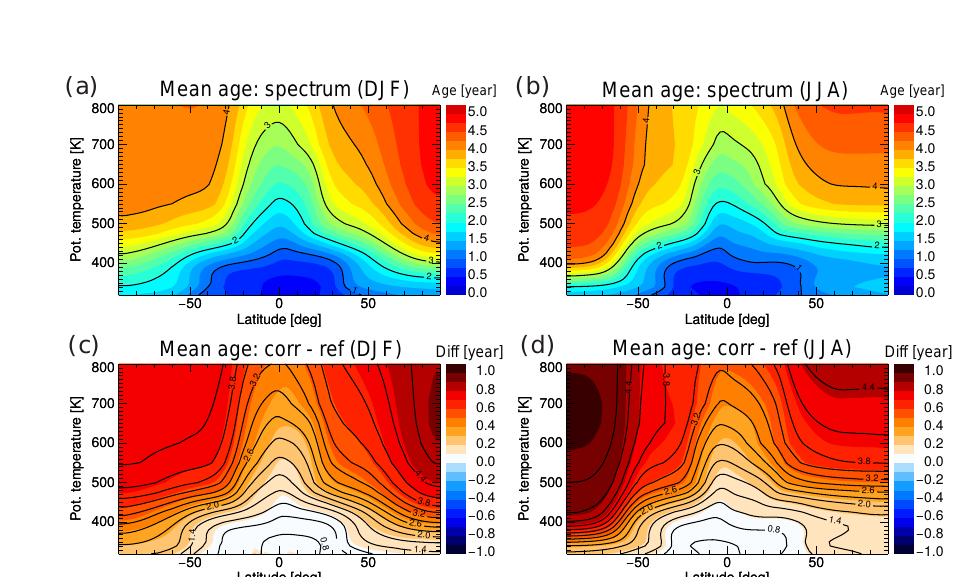
Figure A1. Climatological mean age from CLaMS age spectrum for (a) December–February and (b) June–August, without applying the tail- correction (see text). (c) and (d) show the difference of age spectrum mean ages with correcting for the finite spectrum tail to this reference. Black lines highlight particular mean age